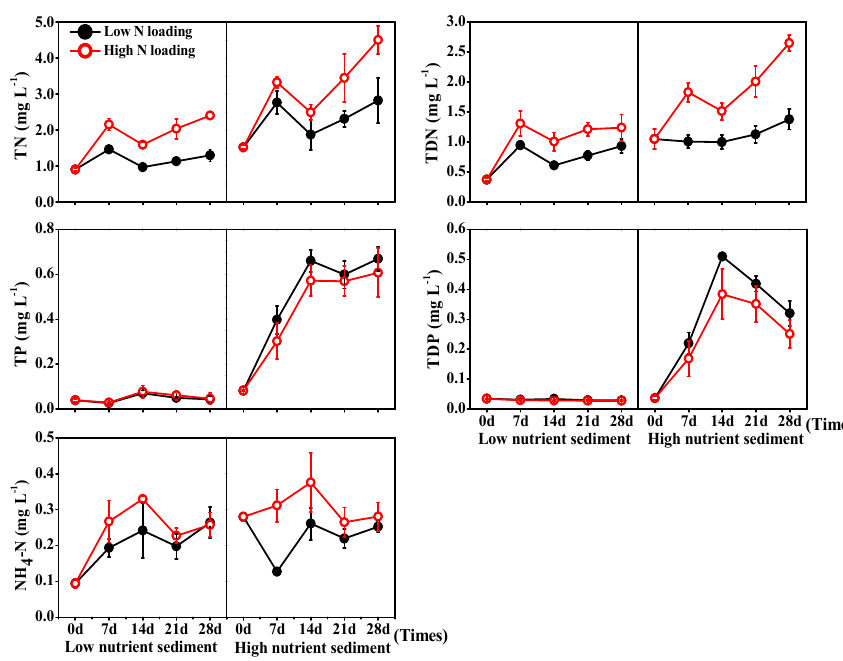
Figure 1. Time series of TN, TP, TDN, TDP and NH 4 ‐ N in different treatments during the experiment. TN, total nitrogen; TDN, total dissolved nitrogen; TP, total phosphorus and TDP, total dissolved phosphorus; NH 4 ‐ N, ammonia nitrogen. Factors are sediment type and external nitrogen loading. Solid circle: low N loading; empty circle: high N loading. Values are mean ± SD, n = 4, and the bars show standard deviation.